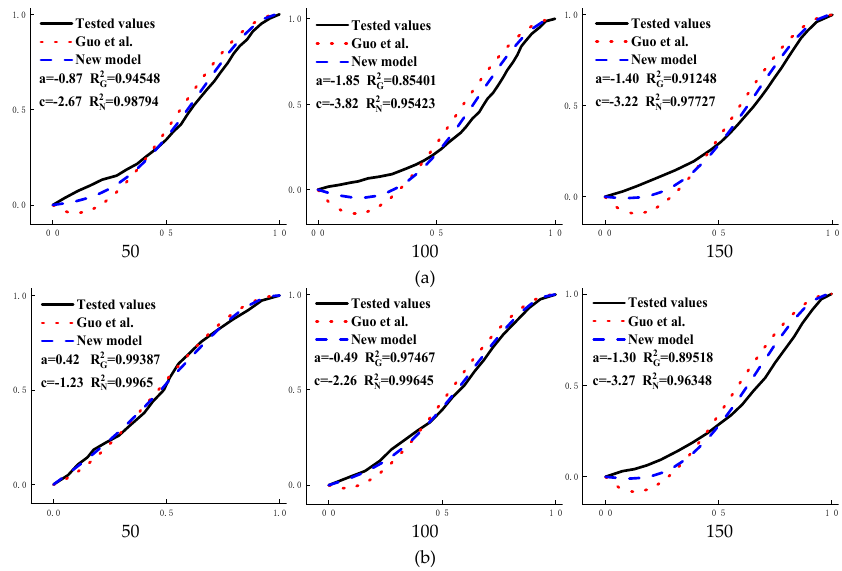
Figure 6. Comparison results between the model of [17] and the new model two: ( a ) O-C40 concrete; ( b ) O-C50 concrete; 50, 100, and 150 are numbers of freeze–thaw cycles.